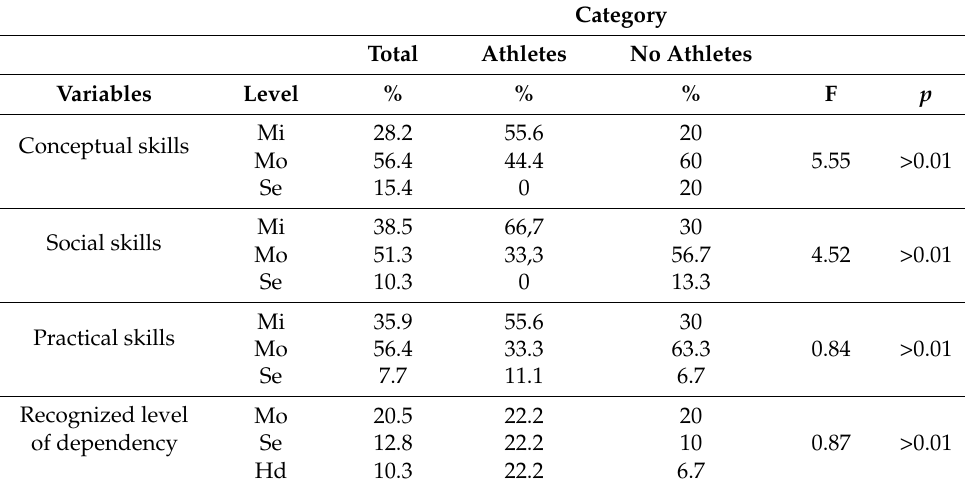
Table 2. Descriptive statistics (%) of the level of intellectual disability and level of dependency recognized of participants with DS ( n = 39).